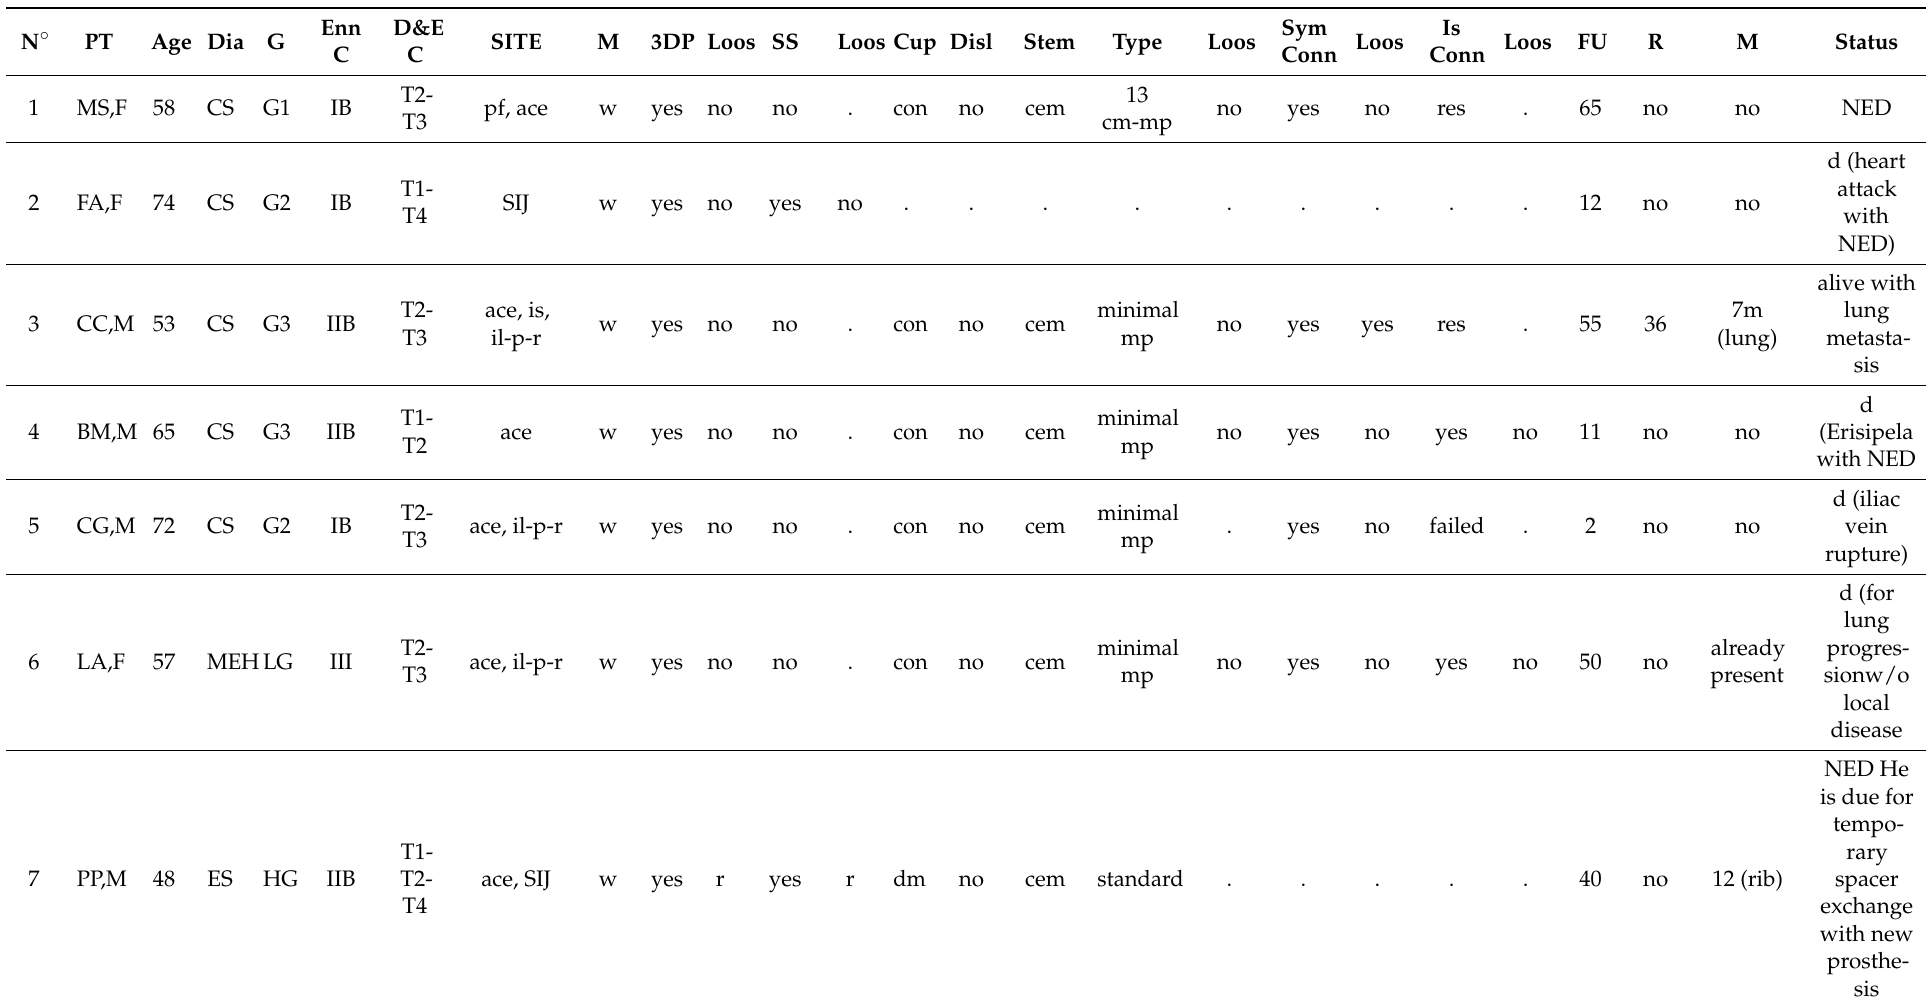
Table 1. Patients’ main